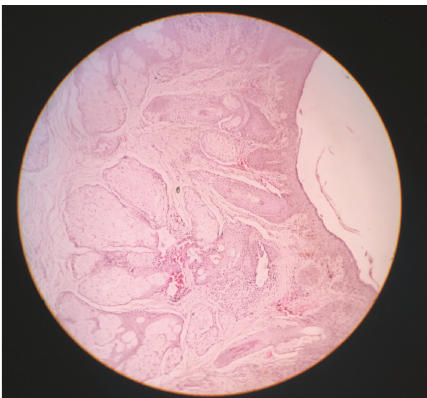
Figure 2: Histopathology: epidermal hyperplasia with spongiosis. Dermis shows villous hair follicle with sebaceous gland hyperplasia with peri-infundibular infiltrate of lymphocytes and plasma cells with dilated capillaries and extravasation of hemosiderin.